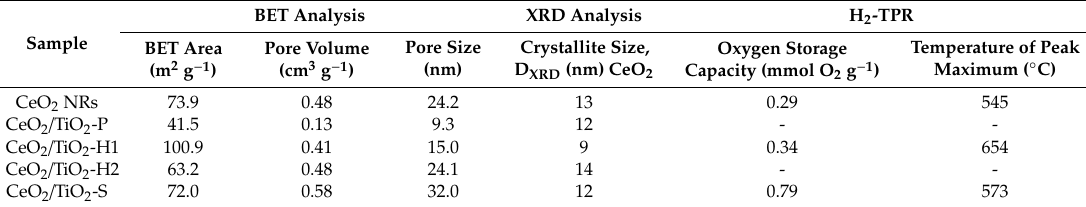
Table 1. Textural/structural, redox properties of CeO 2 and CeO 2 /TiO 2